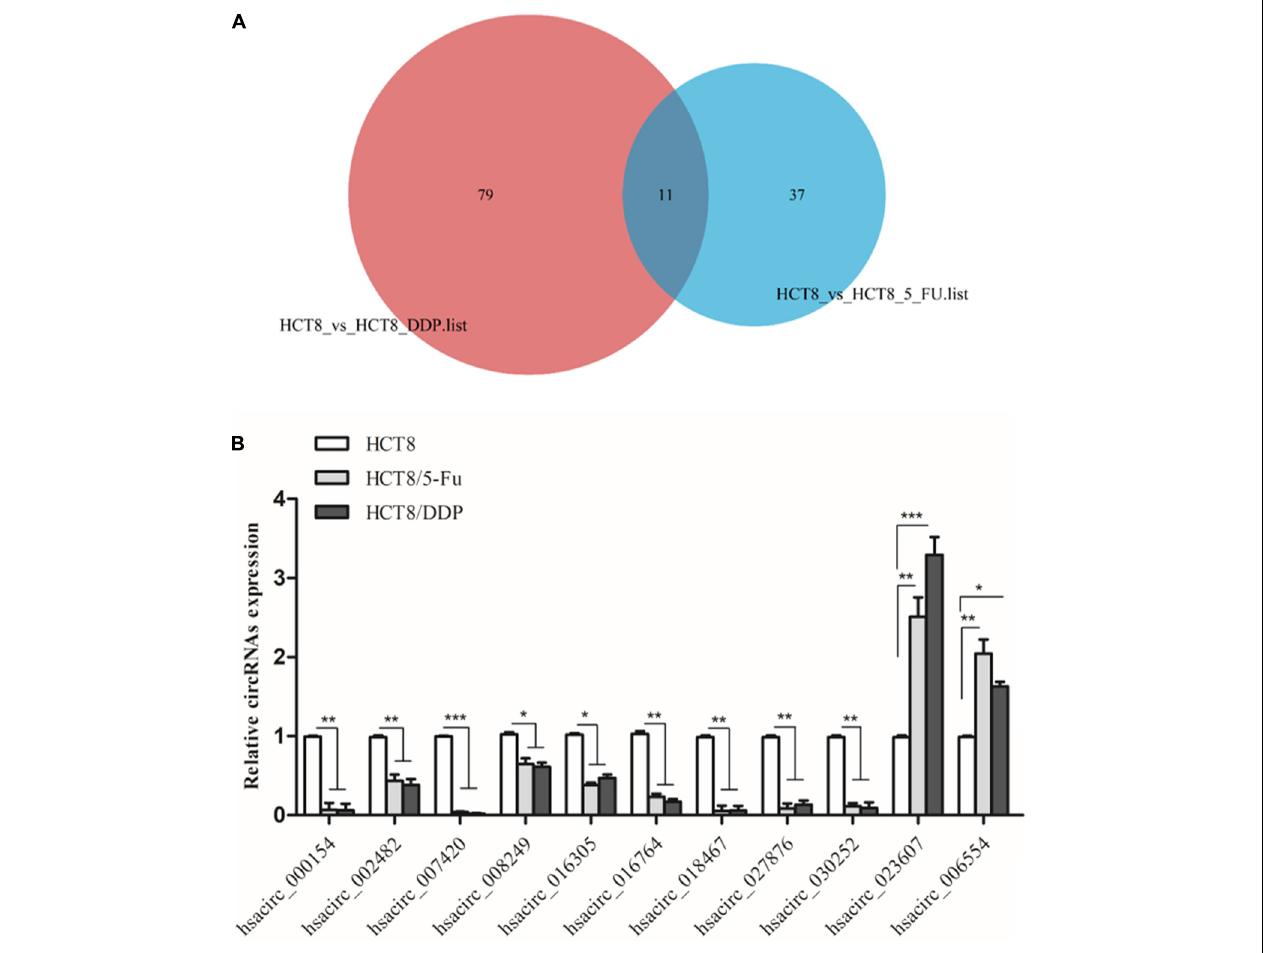
FIGURE 5 | Screening and verification of common DE-circRNAs. (A) Venn diagram displays DE- and overlapping circRNAs between HCT8/5-Fu and HCT8/DDP cell lines. (B) The relative expression levels of common DE-circRNAs in chemoresistant and chemosensitive cell lines were determined by qRT-PCR. n = 3, data are shown as mean ± SD, * p < 0.05; ** p < 0.01 and *** p < 0.001.